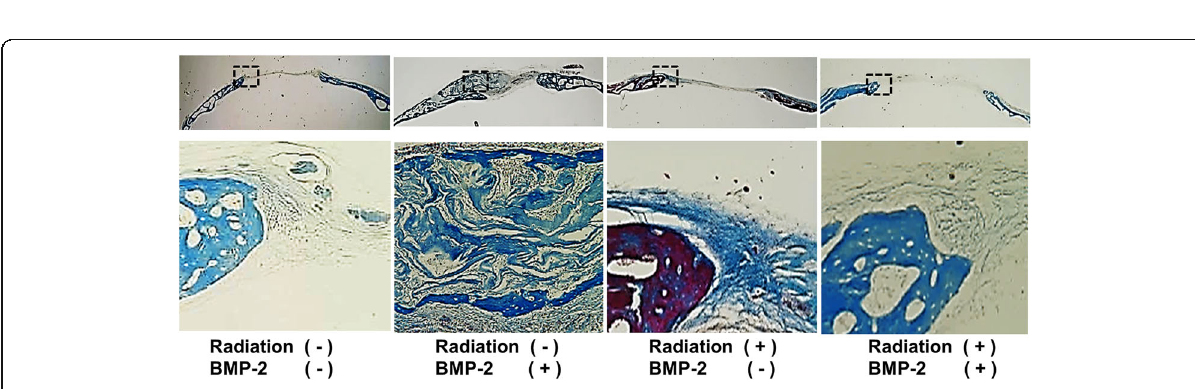
Fig. 5 Histological findings of the calvarial specimen. Trichrome staining. Low (×1) and high magnification